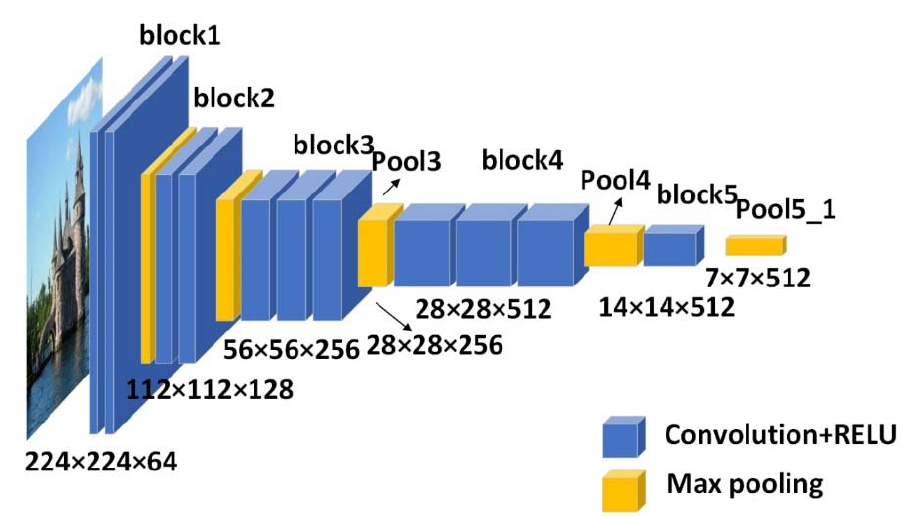
Figure 2. The structure of the deep convolutional network in this paper.